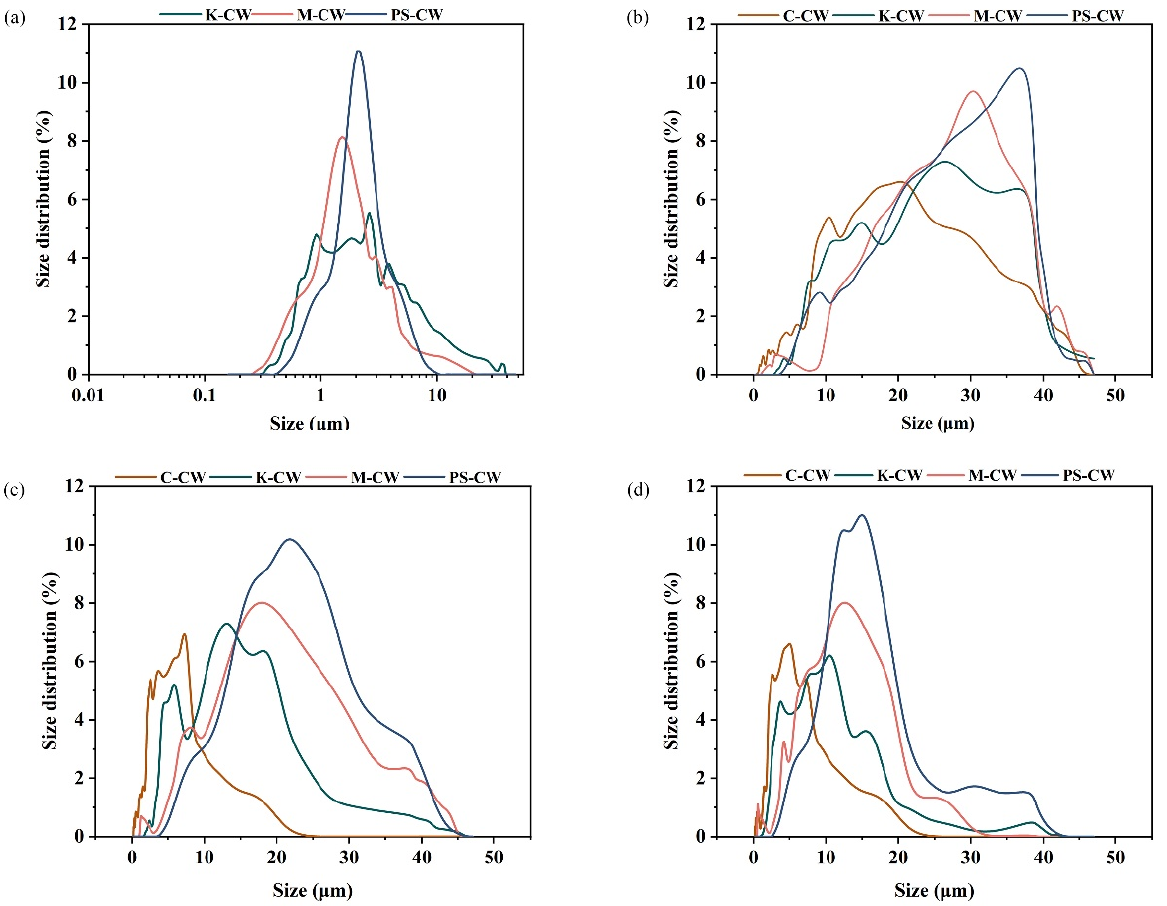
Figure 3. Particle size distribution of PMs ( a ) and accumulated solids at 10–20 cm, 20–30 cm and 30–40 cm ( b – d ) from the bottom of CWs.